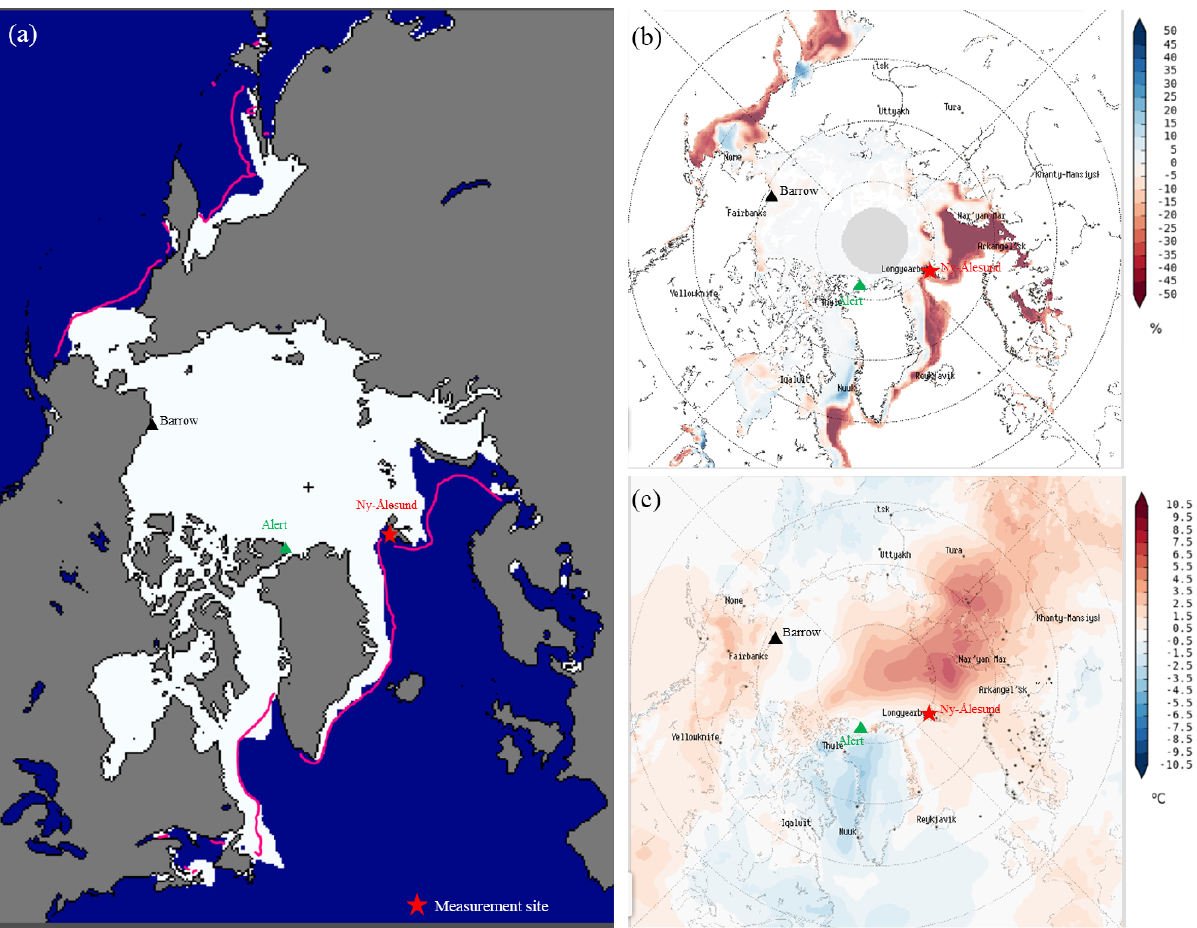
Figure 2. (a) Sea ice extent on April 2015 in the Arctic area (data from http://nsidc.org/data/seaice_index/, last access: 9 July 2018). (b) Monthly mean sea ice concentration anomalies on April 2015 compared to averages from 1979 to 2015. (c) Two meter air tempera- ture anomalies on April 2015 compared to averages from 1979 to 2015. ( b and c data are from http://nsidc.org/soaclast access: 9 July 2018).